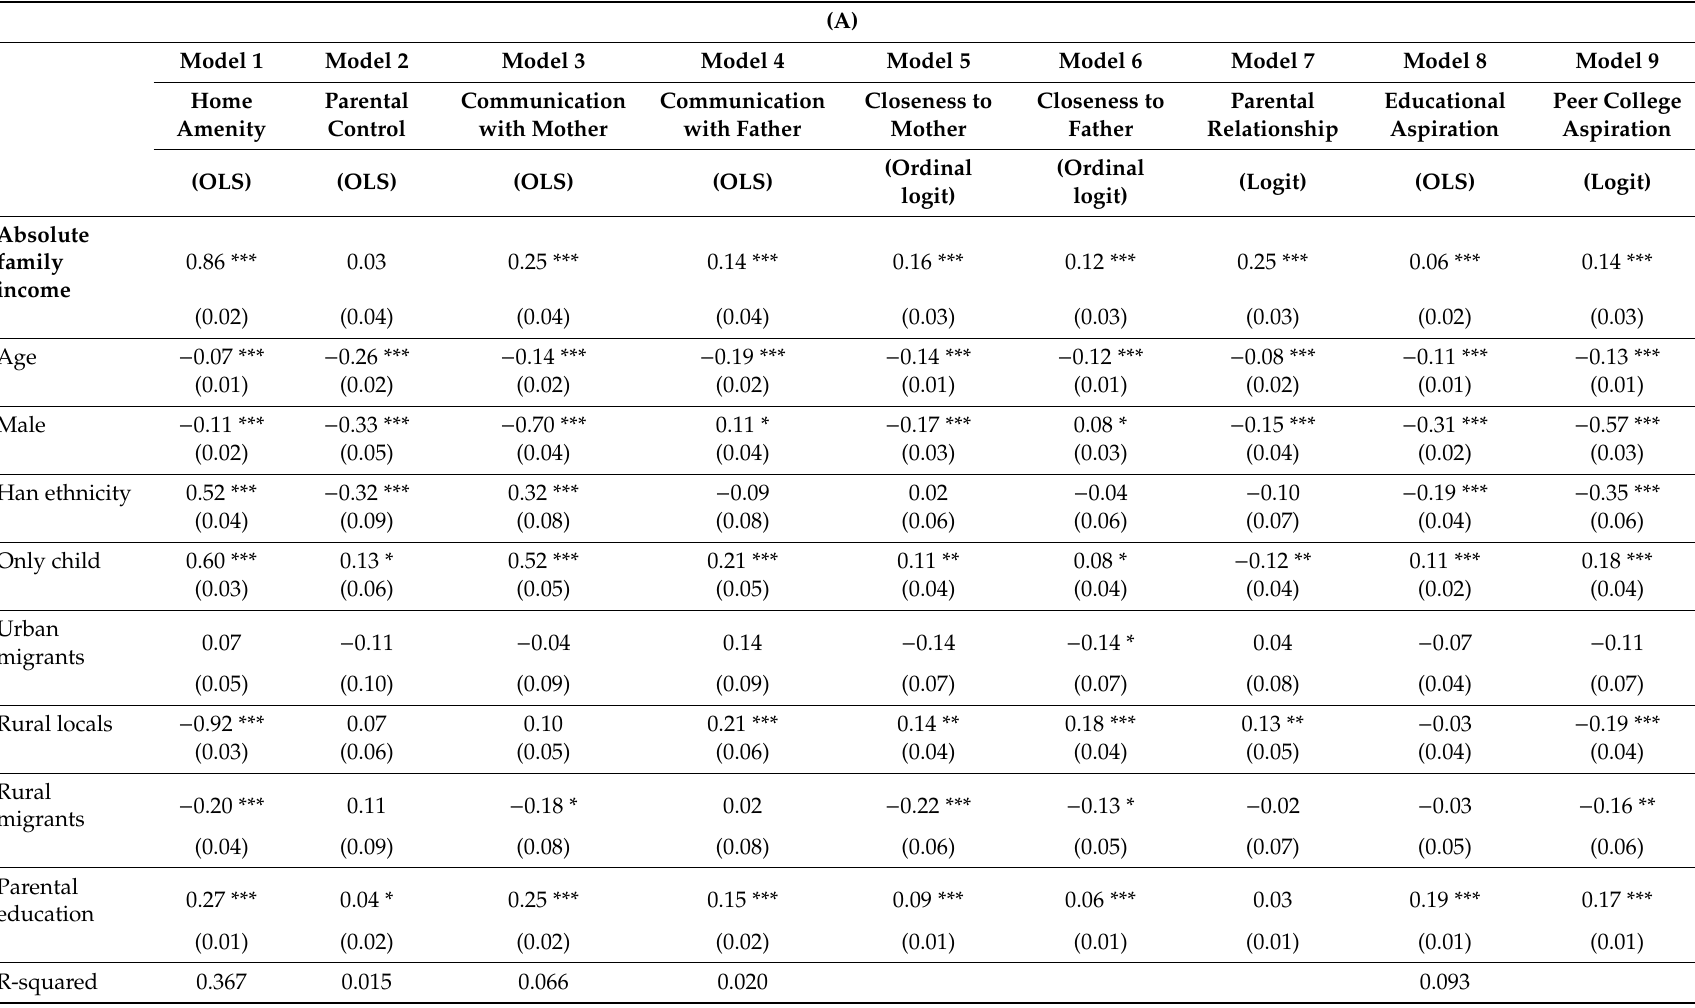
Table 3. ( A ) The Associations between Absolute Family Income and the Hypothesized Mediators. ( B ) The Associations between Relative Family Income and the Hypothesized